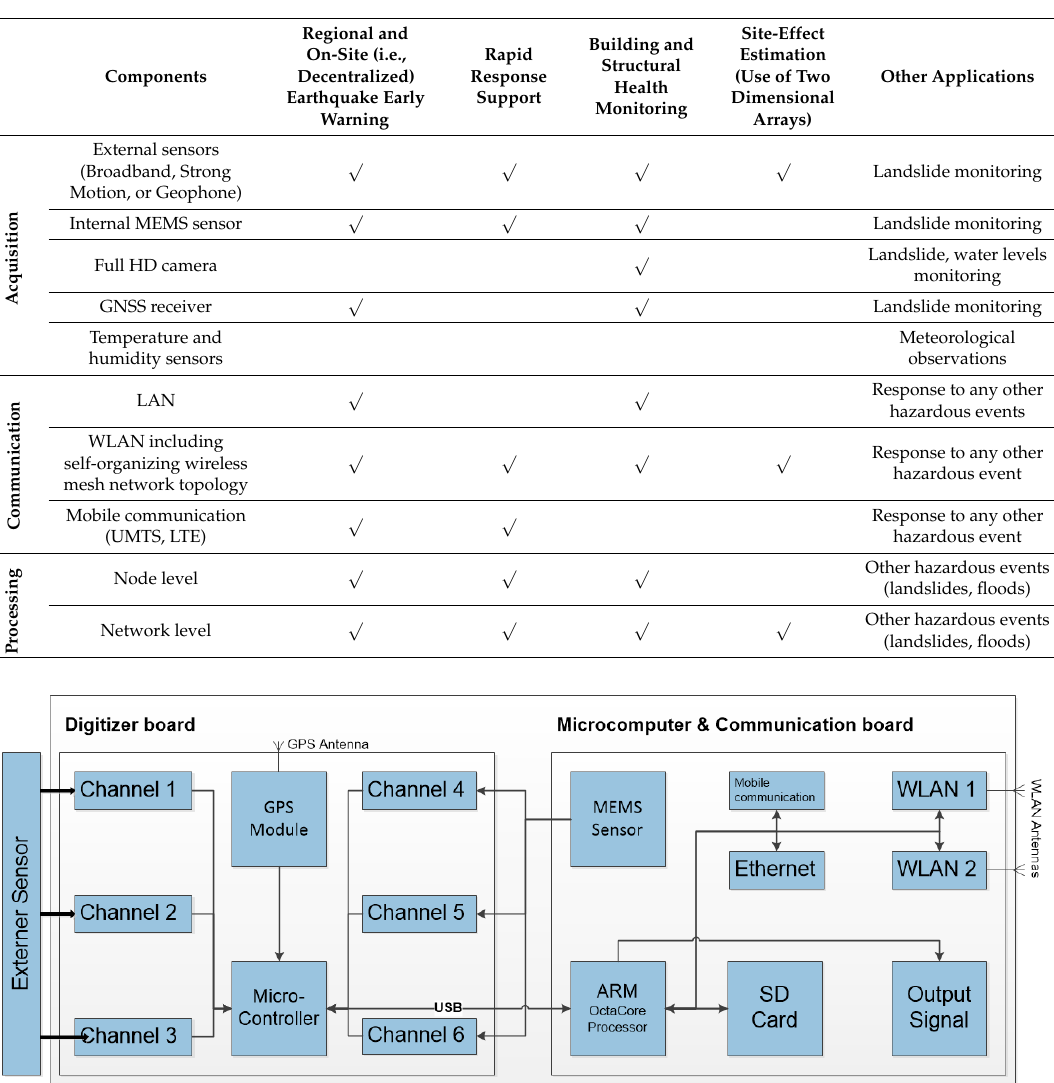
Table 2. The various possible applications of the data acquisition, communications and processing components of the MPwise.